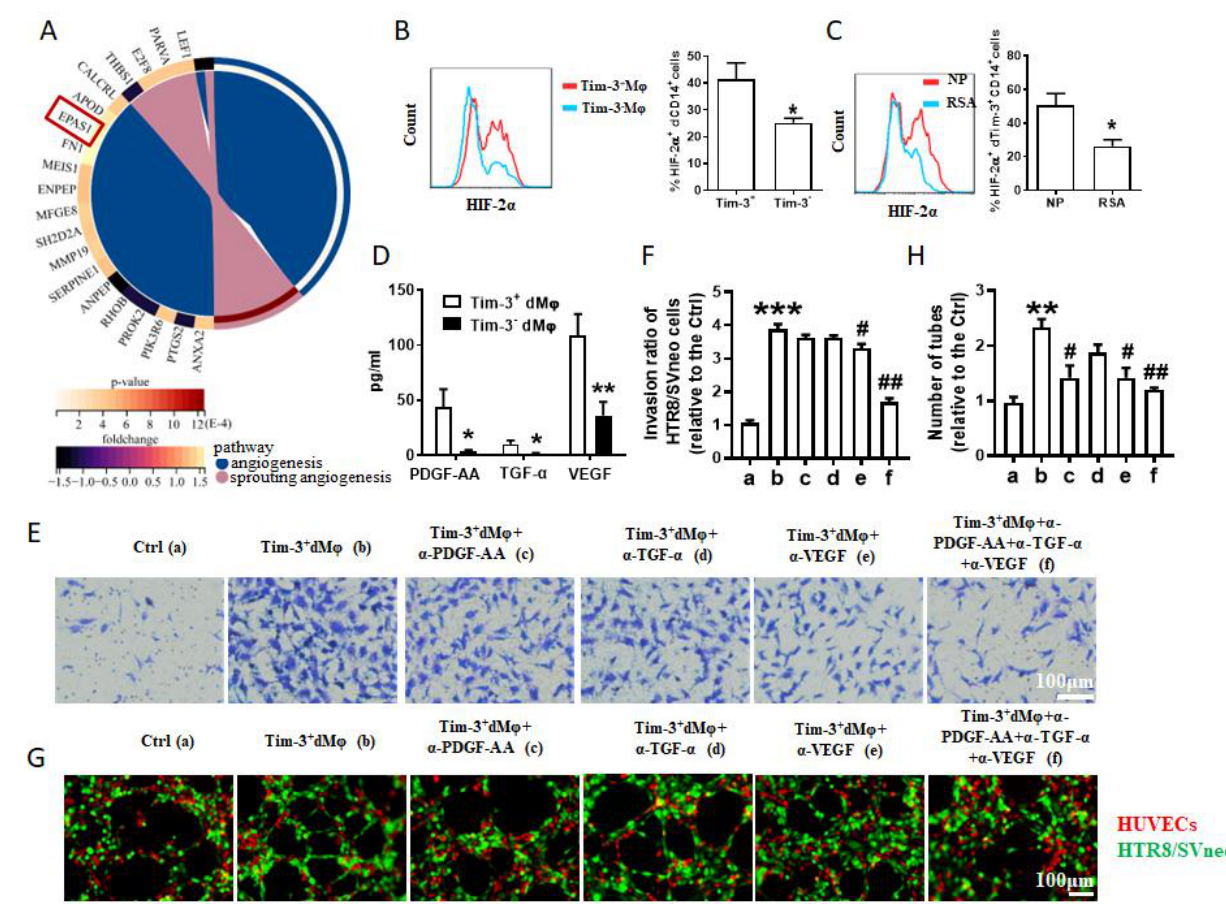
Figure 3. Tim-3 + dMφs promoted invasion and tube formation ability of trophoblasts through angiogenic growth factors. ( A ) Differential expression of angiogenesis- and sprouting angiogenesis – related mRNAs between Tim-3 + dMφs and Tim -3 - dMφs from RNA microarray assay. ( B ) Flow cytometry plots and quantifications of HIF- 2α (the protein product of EPAS1 gene) by human Tim-3 + dMφs and Tim-3 - dMφs ( n = 9). * p < 0.05. ( C ) Flow cytometric analysis and quantification of HIF- 2α on human Tim-3 + dMφs between normal pregnancies (NP, n = 11) and patients diagnosed with recurrent spontaneous abortion (RSA, n = 8). * p < 0.05. ( D ) Levels of PDGF-AA, TGF- α, and VEGF in supernatants of Tim-3 + and Tim-3 - dMφs. * p < 0.05. ( E , F ) Matrigel invasion assays of HTR8/SVneo cells following treatment with Tim-3 + dMφs (pretreated with or without anti -PDGF-AA antibody, and/or anti-TGF- α antibody, and/or anti-VEGF antibody). ( G , H ) Immunofluorescent assay at 4 h of the 3D tube formation by HTR8/SVneo cells (green) and HUVECs (red) with indicated treatment. Data represent the mean ± SEM. ** p < 0.01, *** p < 0.001, compared with group a. # p < 0.05, ## p < 0.01, compared with group b. a: Ctrl, b: Tim-3 + dMφs , c: Tim-3 + dMφs + α -PDGF-AA, d: Tim-3 + dMφs + α -TGF- α , e: Tim-3 + dMφs + α -VEGF, f: Tim-3 + dMφs + α -PDGF-AA+ α -TGF- α + α -VEGF.